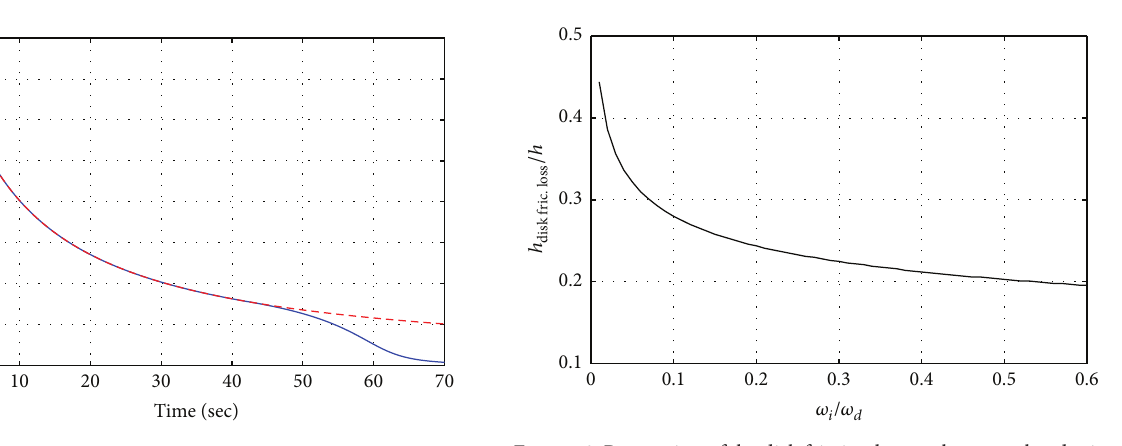
Figure 3: Proportion of the disk friction loss to the pump head raise with the impeller rotating speed.